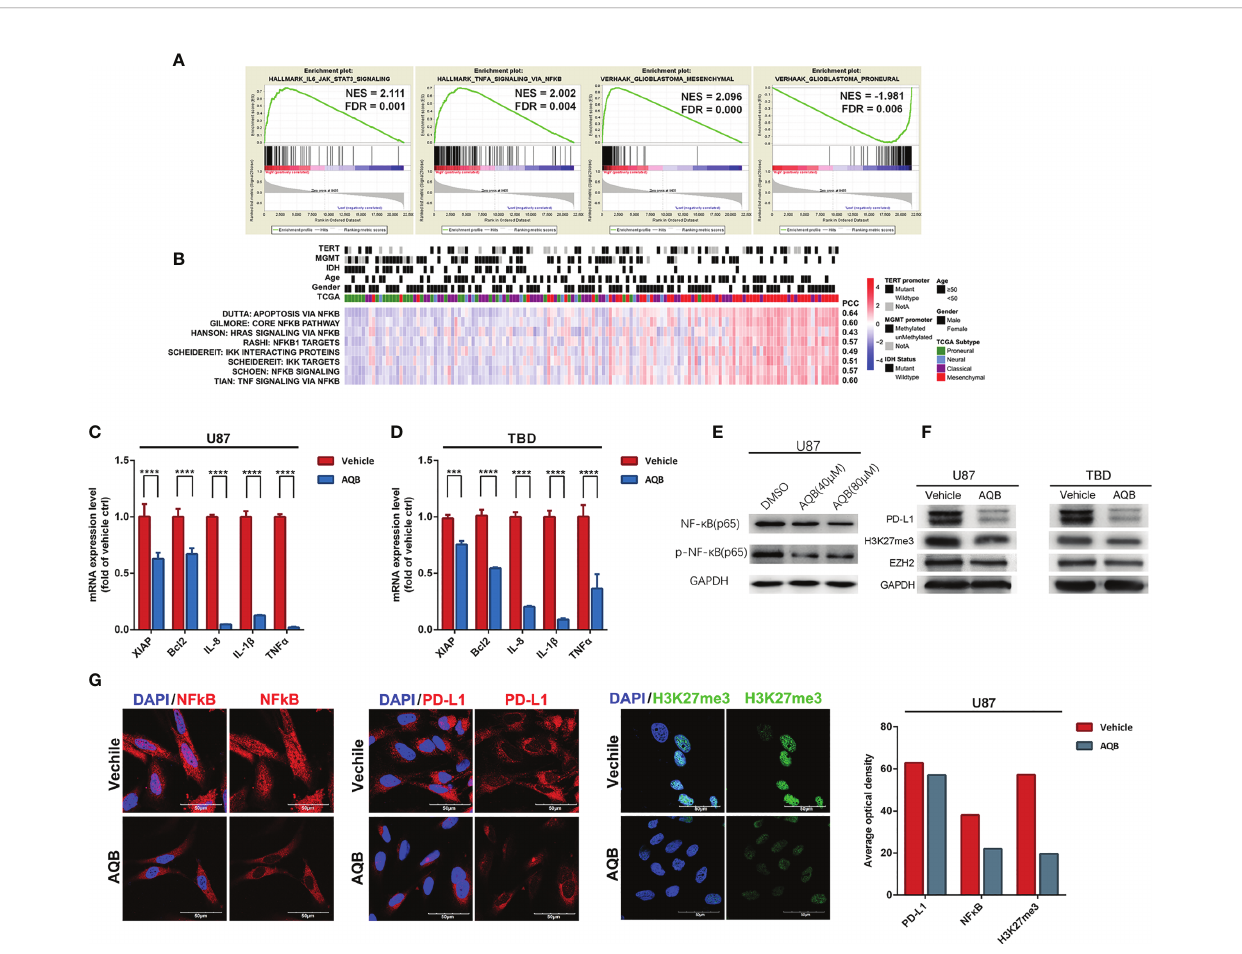
FIGURE 3 | HOTAIR may regulate gene expression pattern in an NF- k B-dependent manner in glioma. (A) The enrichment plots of gene expression signatures of HOTAIR-induced IL6-JAK-STAT3 signaling and TNF a signaling via NF- k B, and the signatures of samples annotated in mesenchymal glioma and proneural glioma, sorted according to the differences between the samples with high and low level HOTAIR expression. (B) Enrichment heatmap showed the NF k B-dependent biological processes associated with the grade of samples. (C, D) NF- k B regulated gene expression levels in U87 (C) and TBD (D) at 24 hours after treatment with AQB. Values are means±s.d. from n=3 independent experiments. The P value was determined by two-sided Student ’ s t-test. (E) Immunobolts detect the protein level of NF- k B and pNF- k B, using GAPDH as control in U87 cells treated with AQB at the concertration of 40 m M and 80 m M. (F) Immunoblots showing the effect of AQB on expression of PD-L1 and EZH2 in U87 and TBD cells, using GAPDH as control. (G) Immuno fl ourescence showing the protein level and protein distribution of H3K27me3, NF- k B and PD-L1 in DMSO or AQB treated U87 cells. The bar chart indicates differences in the mean optical densities of NF- k B, PD-L1, and H3K27me3 proteins in DMSO or AQB-treated U87 cells. Scale bar, 50 m m. *** P < 0.001, **** P <